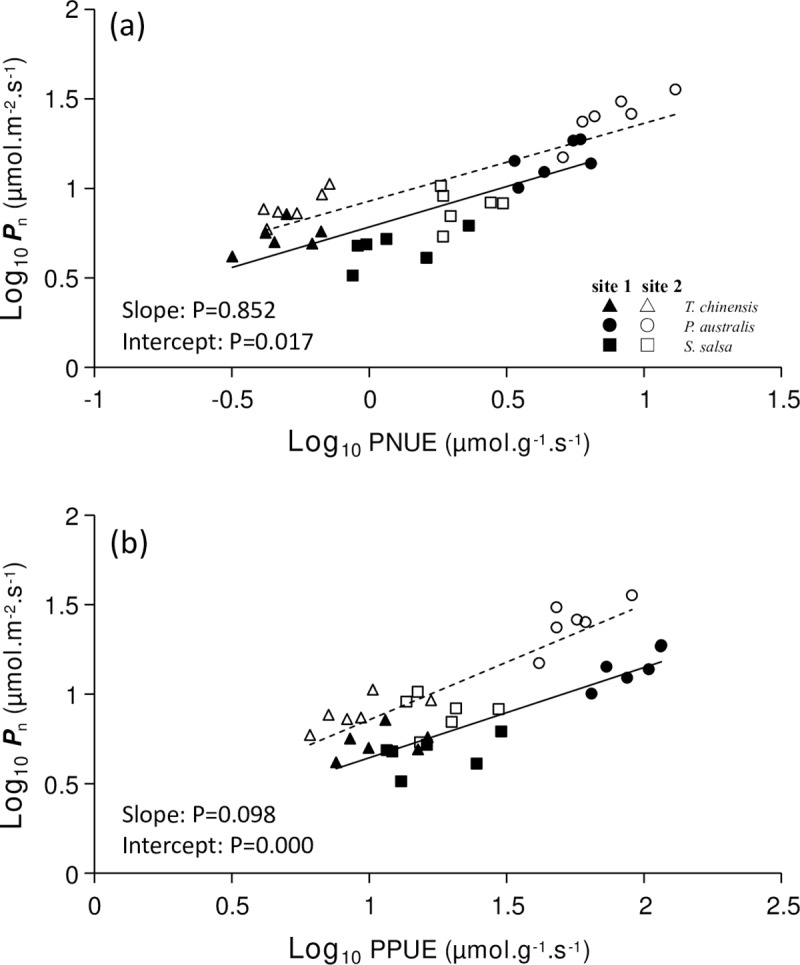
Relationships between photosynthetic nutrient use efficiency and Pn of halophytic plant communities.(a) PNUE and Pn (equation for site 1: y = 0.4522x+0.7842, R2 = 0.679, P < 0.001; equation for site 2: y = 0.4345x + 0.9289, R2 = 0.676, P < 0.001; with data log10-transformed); (b) PPUE and Pn (equation for site 1: y = 0.5042x + 0.1405, R2 = 0.812, P < 0.001; equation for site 2: y = 0.6439x + 0.2127, R2 = 0.752, P < 0.001; with data log10-transformed).